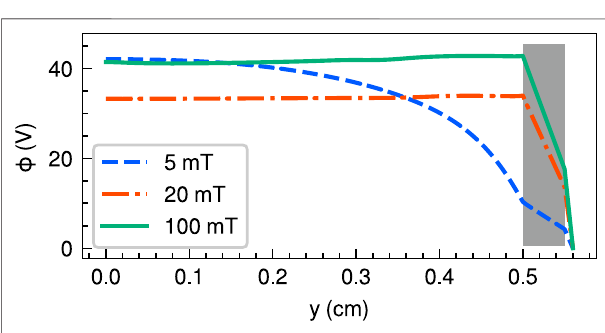
FIGURE 5 | y pro fi les of the potential ϕ at x (cid:1) 1.1 cm for the three magnetic fi eld strengths of5 (a dashed blue line), 20 (a dotted-dashed orange line), and 100 mT (a solid green line). A gray box shows the location of the dielectric wall.